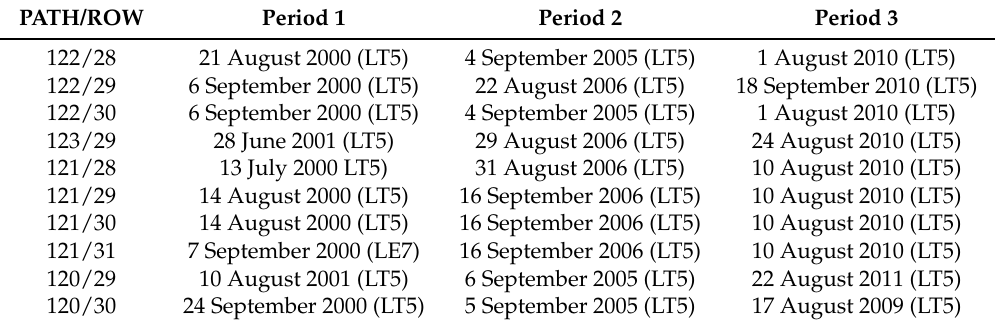
Table 1. List of images used for validation in this